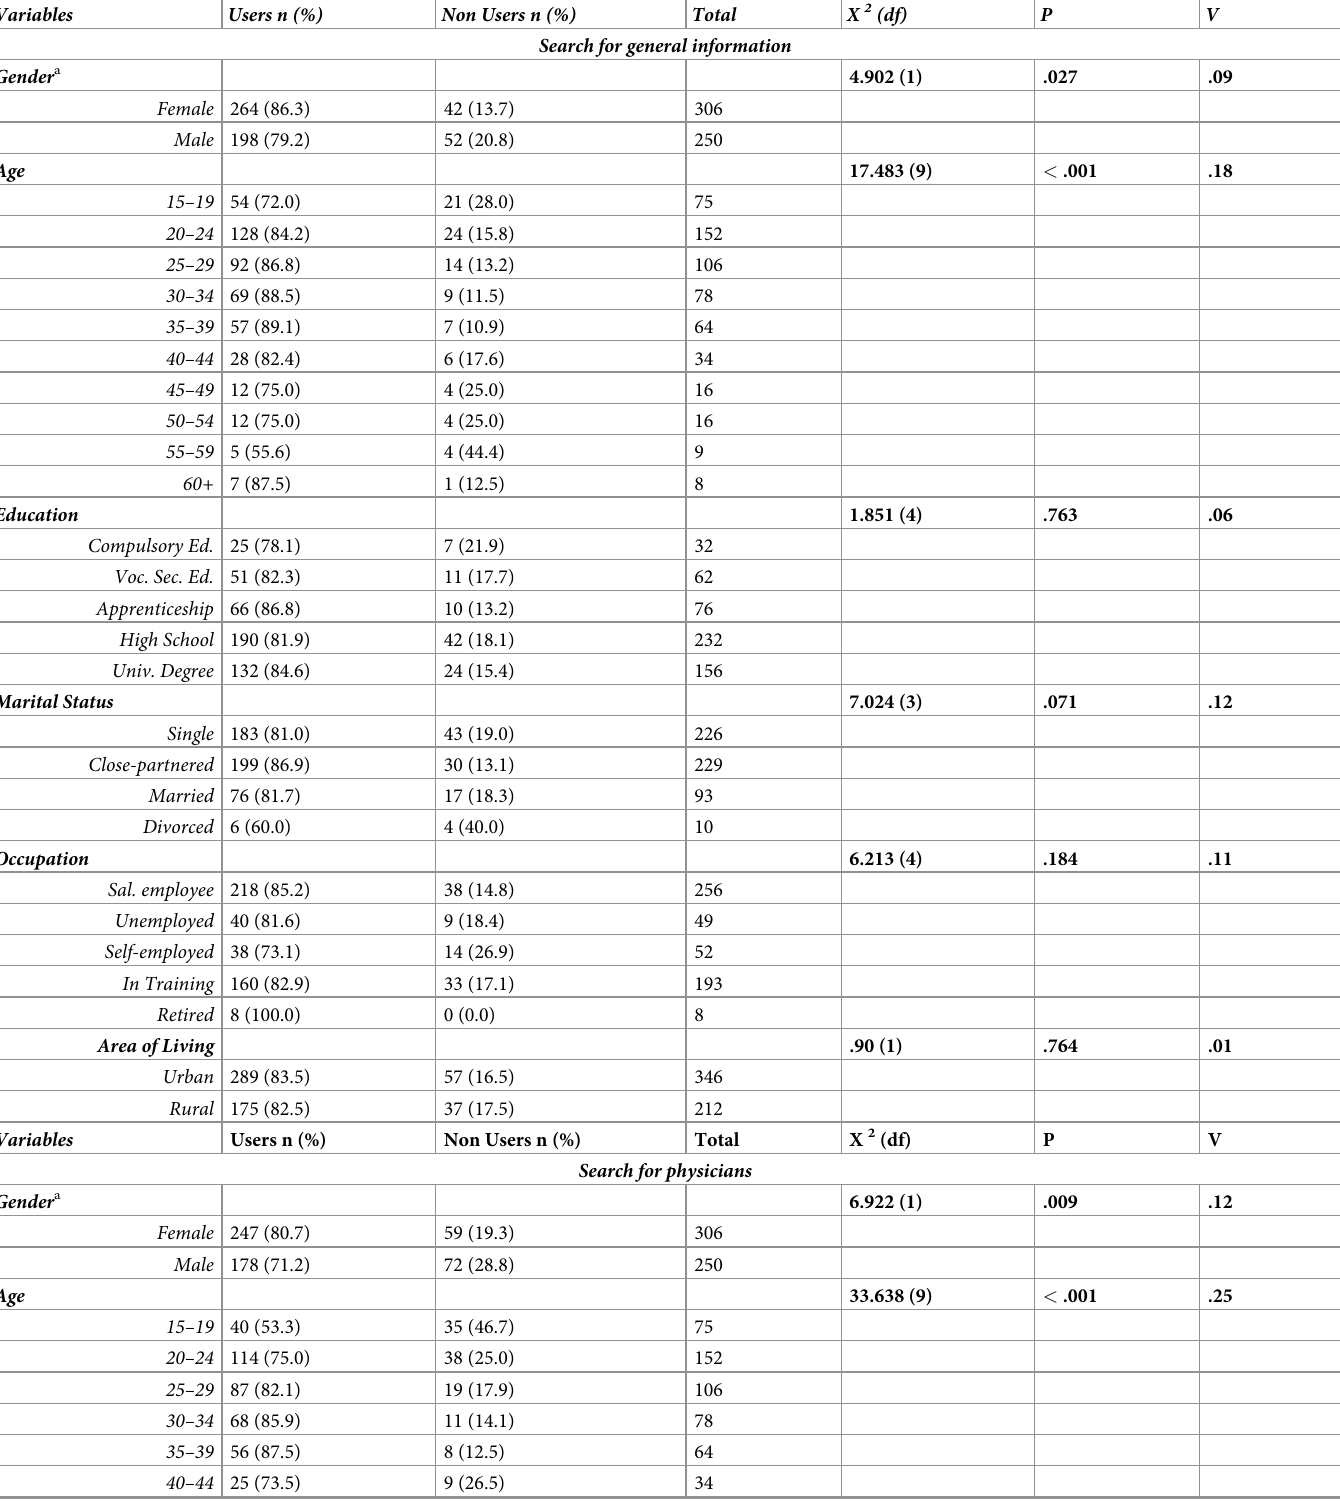
Table 7. Types of interaction with PRWs and association with demographic